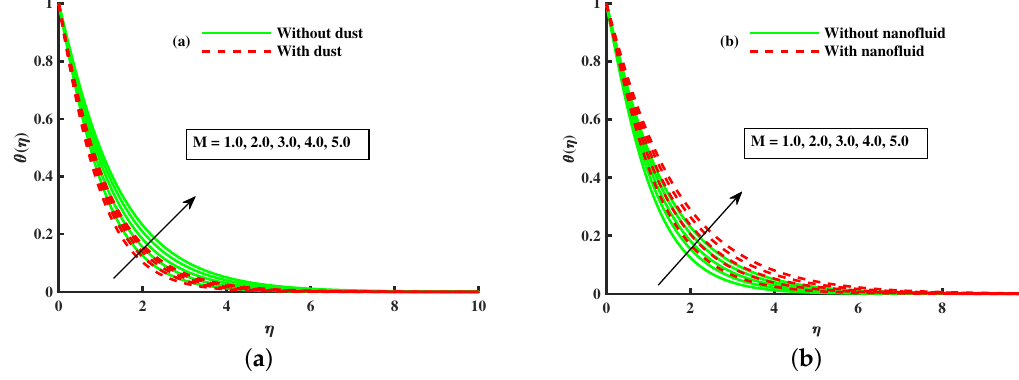
Figure 19. Fluctuation of M on θ ( η ) ( a ) and effect of M on θ ( η ) ( b ).